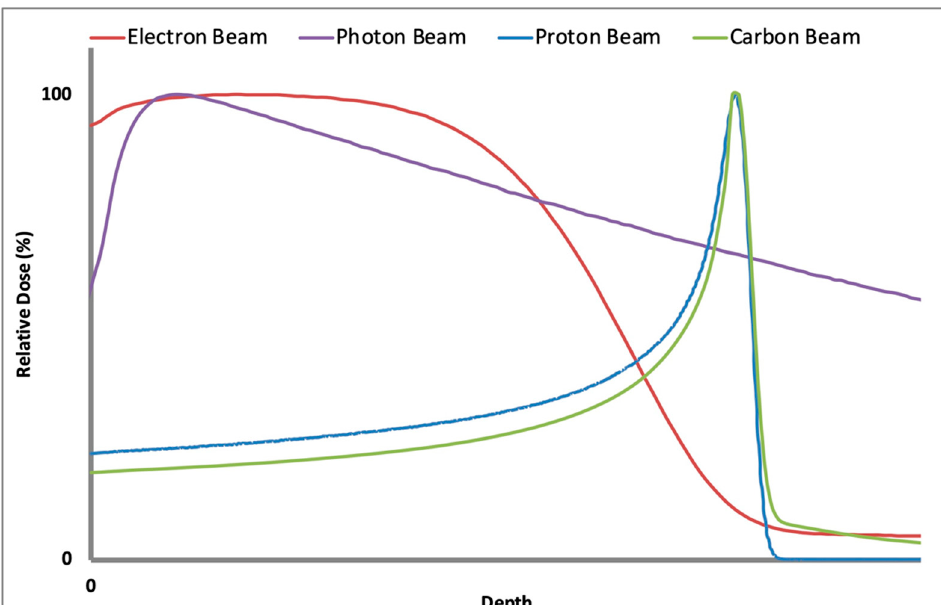
Figure 1. A graphical representation of tissue depth as a function of relative dose with the former on the x -axis and the latter on the y -axis. The purple graph depicts a photon beam, the red—an electron beam, the green—a carbon ion beam, and the blue—a proton beam. Both the proton and carbon ion beams exhibit significant Bragg Peaks, which are absent for photons and electrons. Additionally, the fragmentation tail associated with carbon ions is depicted. Note the absence of a sharp Bragg Peak for photons and its significant tissue penetration. Electron beams are largely used for superficial treatments (e.g., basal cell carcinomas of the skin) and exhibit a rapid dose fall-off and low tissue penetration.